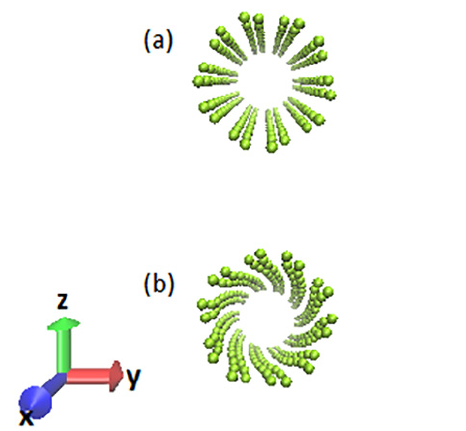
Figure 5. Schematic view of an armchair SWSiNT with C-F boundary conditions (a) before torsional deformation and (b) after initial torsional deformation.